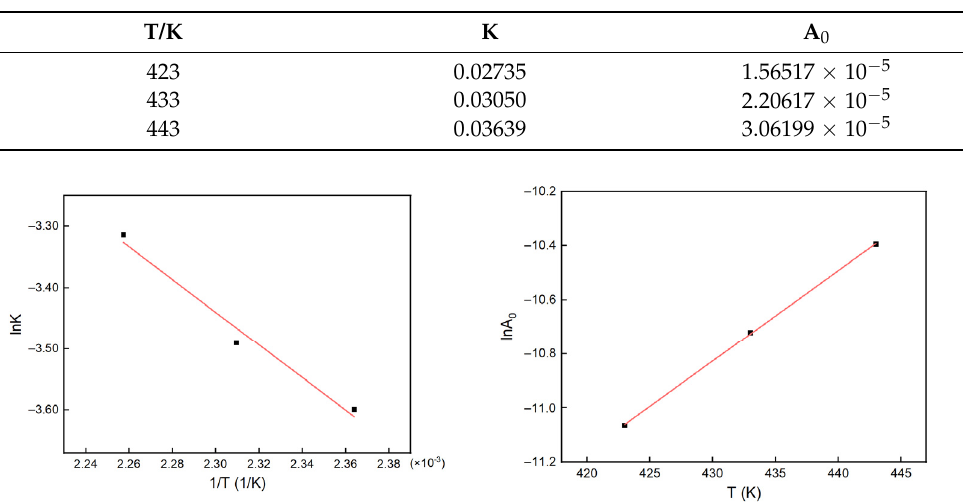
Figure 19. Fitting lines for K and A (cid:2868) .